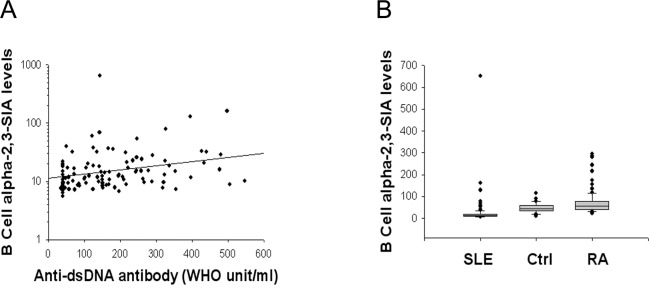
B-cell α-2,3-sialic acid (SIA) levels in systemic lupus (SLE), healthy controls (Ctrl), and rheumatoid arthritis (RA).B-cell α-2,3-SIA levels indicated the mean fluorescence intensity of the B-cell’s SIA staining results. (A) Positive correlation between B-cell α-2,3-SIA levels and serum anti-dsDNA antibody levels (WHO unit/ml) (n = 106). Using a staining method similar to that described in Fig 1, the second layer of staining used FITC-conjugated Macckia amurensis lectin to bind cell surface α-2,3-SIA. WHO: World Health Organization. The correlation was ρ = 0.313 and P = 0.001. (B) Comparison of B-cell α-2,3-SIA levels among various groups. SLE (n = 106) vs. Ctrl (n = 31) gave P<0.001; SLE vs. RA (n = 157) rendered P<0.001; RA vs. Ctrl gave P = 0.011. All were significant when Bonferroni’ correction was done to make a significant P-value at 0.0167.